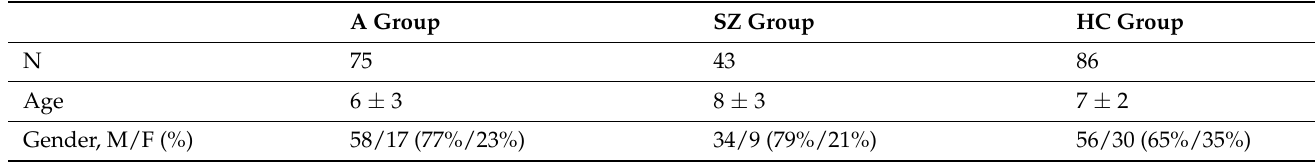
Table 1. Clinic and demographic description of the study